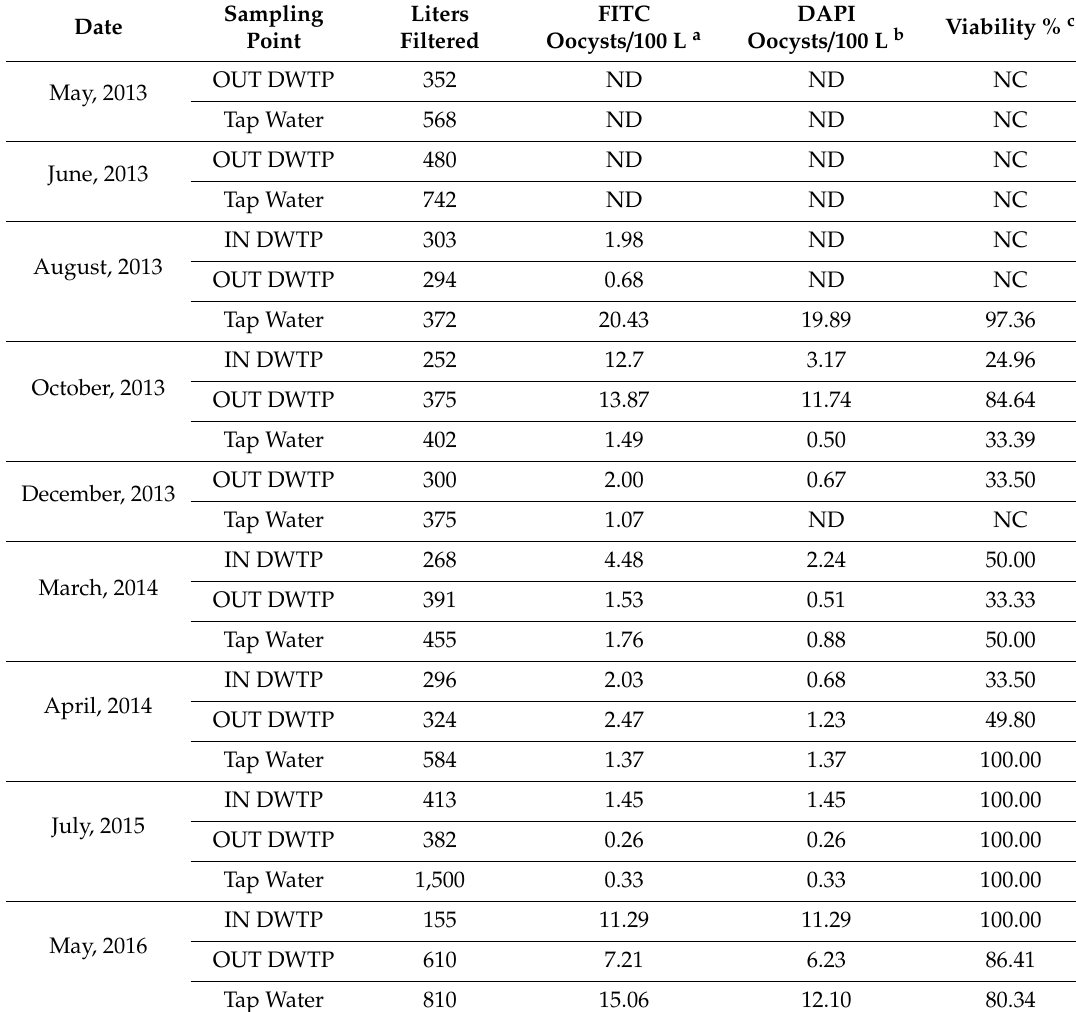
Table 1. Details of sampling; concentrations and viability of Cryptosporidium spp. in the di ff erent water samples